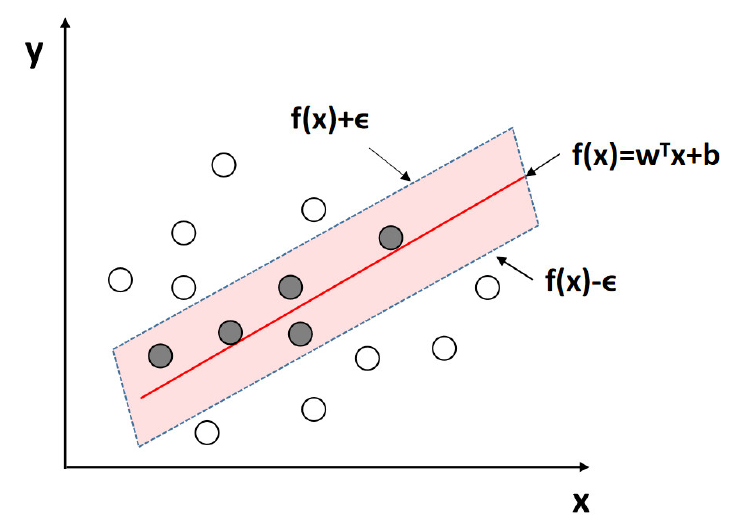
Figure 2. SVM Figure 2. SVM algorithm.